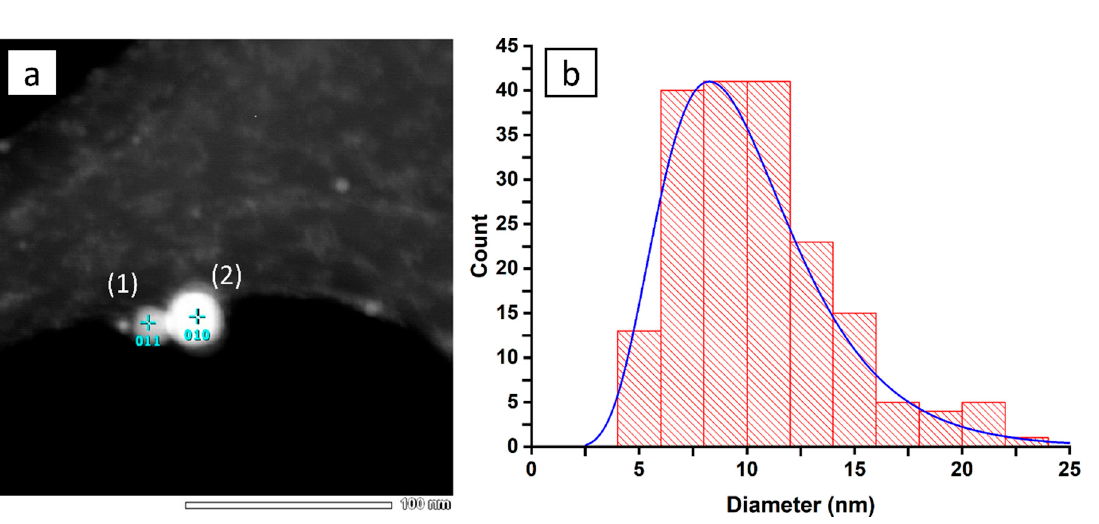
Figure 3. ( a ) TEM image of the nickel nanoparticles along with indicators showing EDX measurement sites, ( b ) histogram of the nanoparticle size distribution.